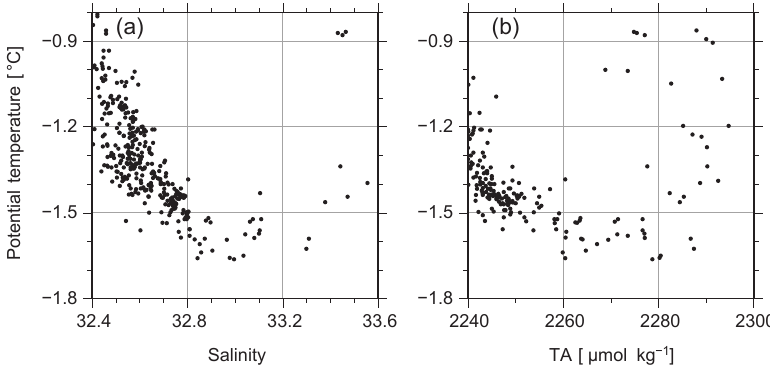
Figure 1. Water properties around the temperature minimum layer in the Chukchi Sea and the Canada Basin in samples collected during cruise MR13-06 from 3 September to 1 October 2013. Potential temperature versus (a) salinity and (b) total alkalinity (TA).